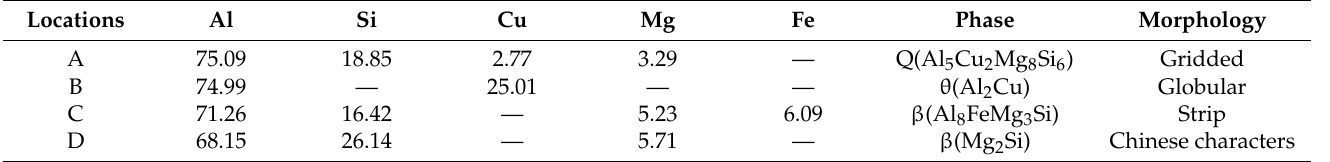
Figure 7. Microstructure of the Al − 17Si − 4Cu − xMg alloys. ( a ) OM microstructure, ( c ) High magnification SEM microstructure and ( e ) LOW magnification SEM microstructure of Al−17Si−4Cu−0.5Mg; ( b ) OM microstructure, ( d ) High magnification SEM microstructure and ( f ) LOW magnification SEM microstructure of Al − 17Si − 4Cu − 2.5Mg. Table 4. EDS analyses on various phases observed from Figure 7 (at